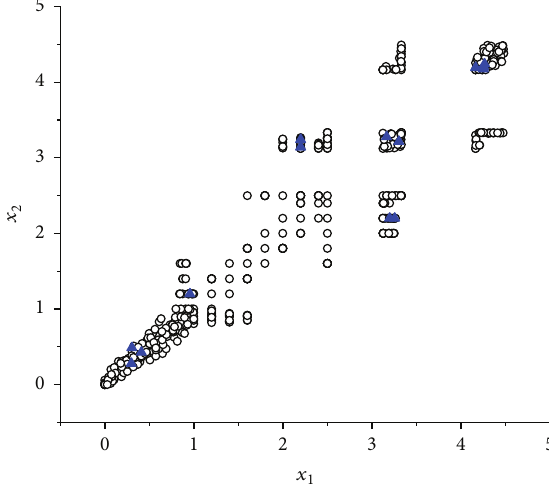
Figure 2: The obtained non-dominated solutions of M-BINH problem, projected in objective space.